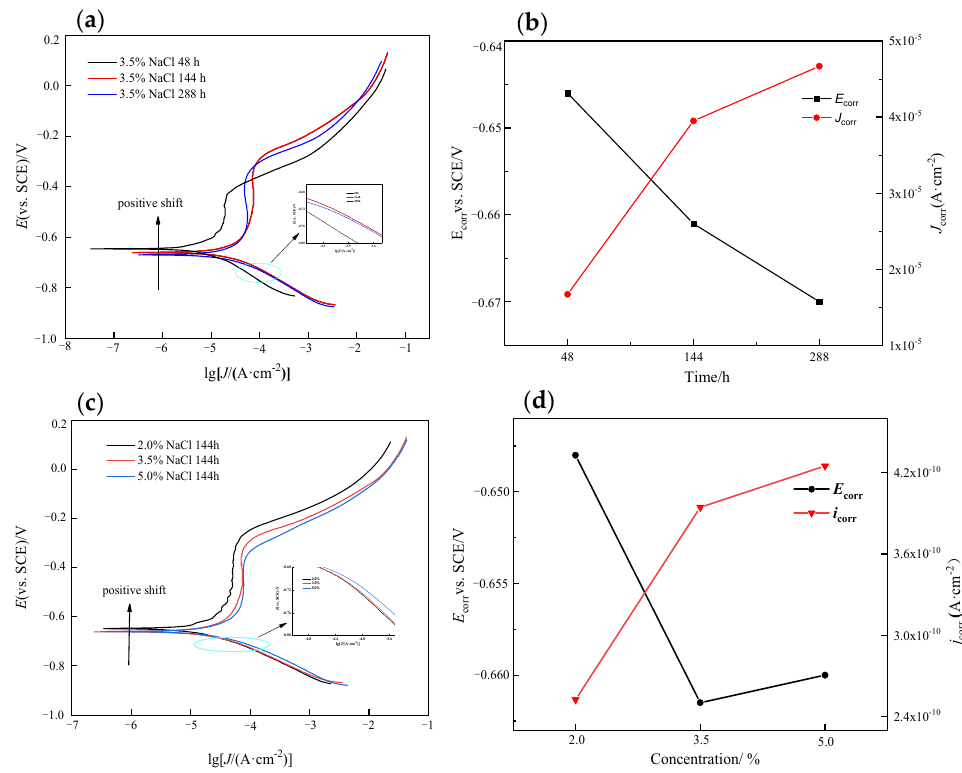
Figure 9. Potentiodynamic polarization curves of specimens under different conditions: ( a ) different immersion times; ( b ) fitting results with immersion time; ( c ) different concentrations; and ( d ) fitting results with concentration.